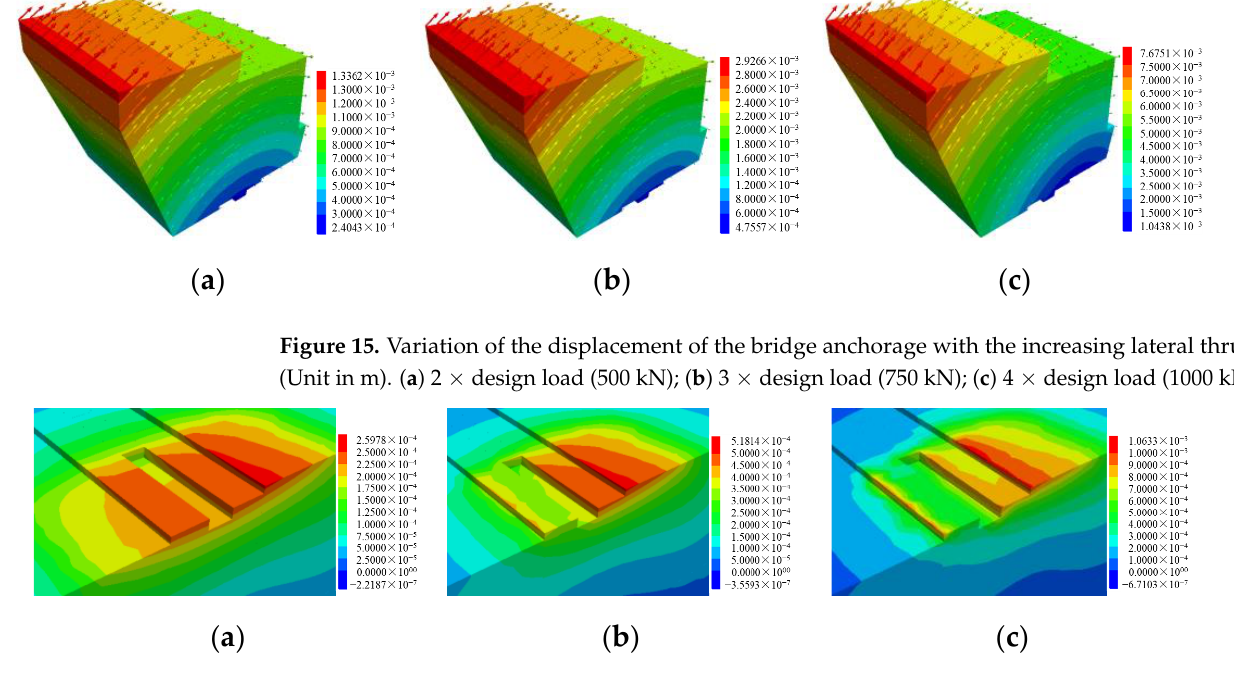
Figure 17. Variation of the contact normal stress on the rock-concrete interface with the increasing lateral thrust. (Unit in Pa). ( a ) 2 × design load (500 kN); ( b ) 3 × design load (750 kN); ( c ) 4 × design load (1000 kN). Figure 18. Variation of the contact shear stress on the rock-concrete interface with the increasing lateral thrust. (Unit in Pa). ( a ) 2 × design load (500 kN); ( b ) 3 × design load (750 kN); ( c ) 4 × design load (1000 kN). Figure 19. Variation of yield state of the rock-concrete interface with the increasing lateral thrust. ( a ) 2 × design load (500 kN); ( b ) 3 × design load (750 kN); ( c ) 4 × design load (1000 kN).